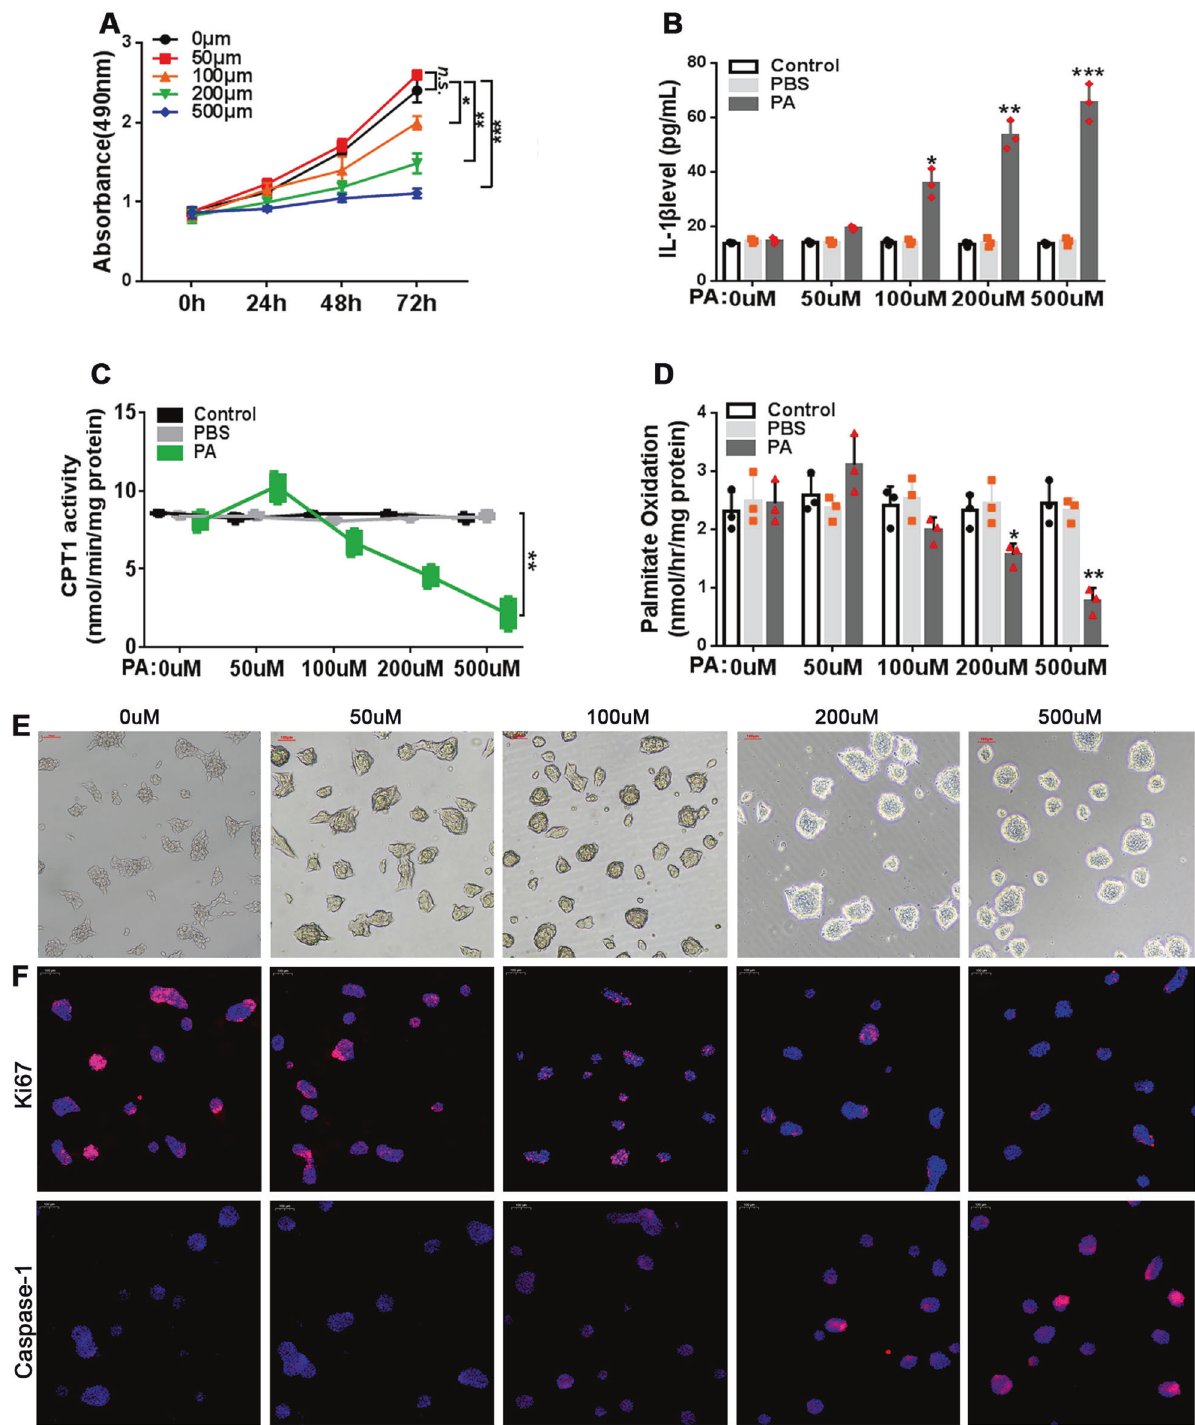
Fig. 2 PA induces an in fl ammatory response in AR42J cells in vitro. A AR42J cells were treated with PA at the indicated concentrations for up to 72 h. Cell viability was determined using the CCK-8 assay. B – F AR42J cells were treated with PA at the indicated concentrations for 12 h. B IL-1 β levels were measured in the culture supernatant by ELISA. C CPT1 enzymatic activity was assessed. D The rate of fatty acid oxidation was determined by analyzing palmitate oxidation levels. n = 3; * P < 0.05, ** P < 0.01, *** P < 0.001 (or vs. 0 μ M P A); n.s. = no statistically signi fi cant differences. E Phase contrast microscopy was used to visualize morphological changes in the cells. F Representative immuno fl uorescence images showing Ki67 (upper panel) and caspase-1 (lower panel) staining. Red, Ki67, or caspase-1; blue, DAPI, scale bar = 100 μ